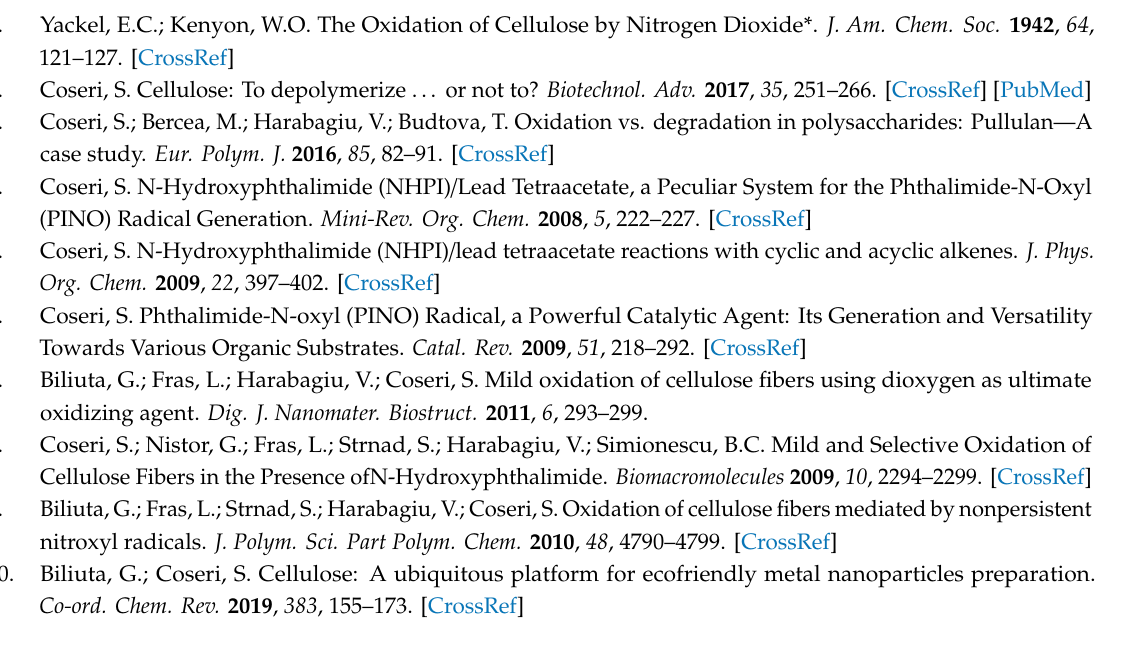
Figure S1: The 13 C-NMR spectra of PI – APS, Figure S2: The 13 C-NMR spectra of PII – APS, Figure S3: The 13 C-NMR spectra of PI – AMPS, Figure S4: The 13 C-NMR spectra of PII – AMPS, Figure S5: The 13 C-NMR spectra of PI – BMPS, Figure S6. The 13 C-NMR spectra of PII –